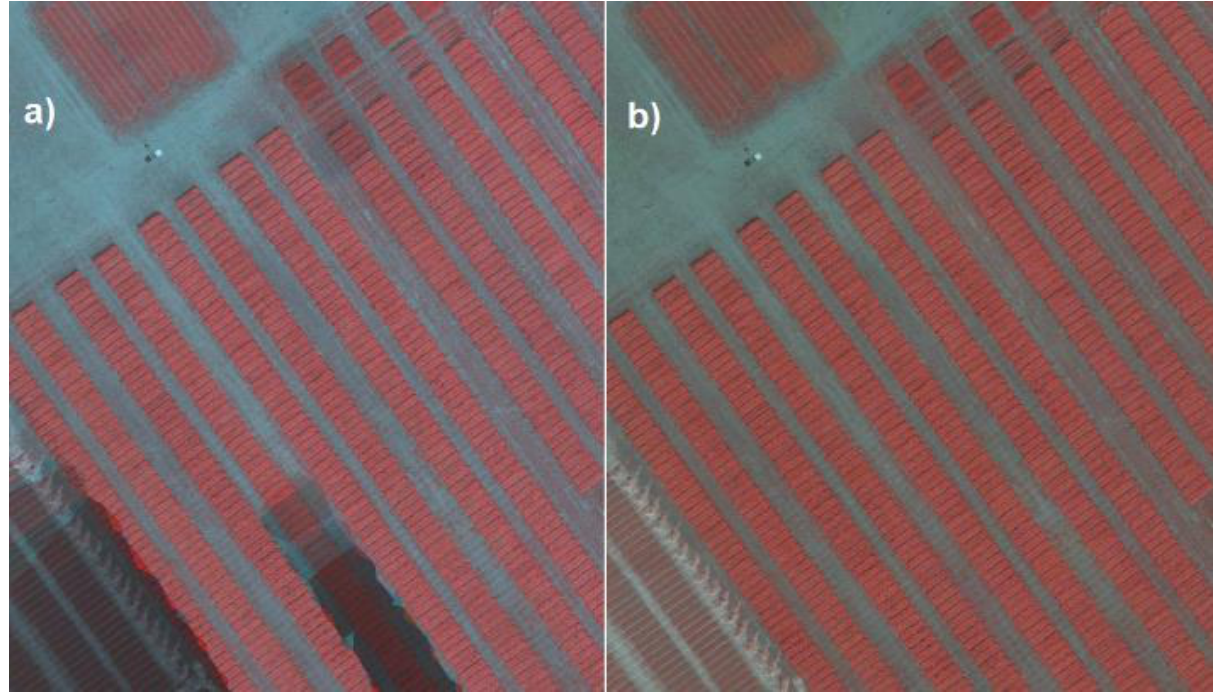
Figure 6. Example false colour reflectance image mosaic of the test area. a) plain ortho, b) with image- and band-wise AIRS irradiance